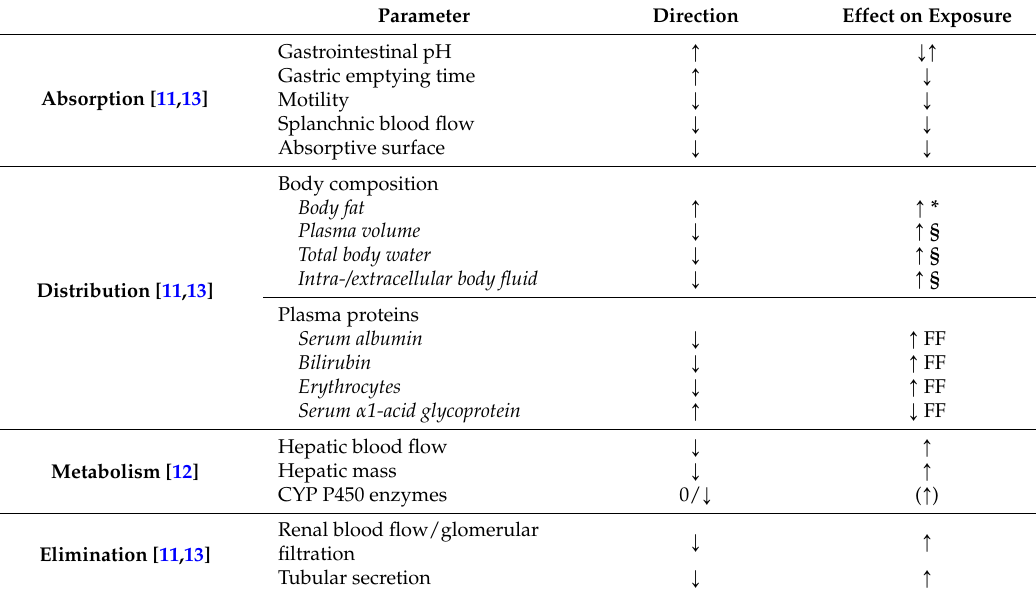
Table 1. Influence of aging on pharmacokinetics (PK)